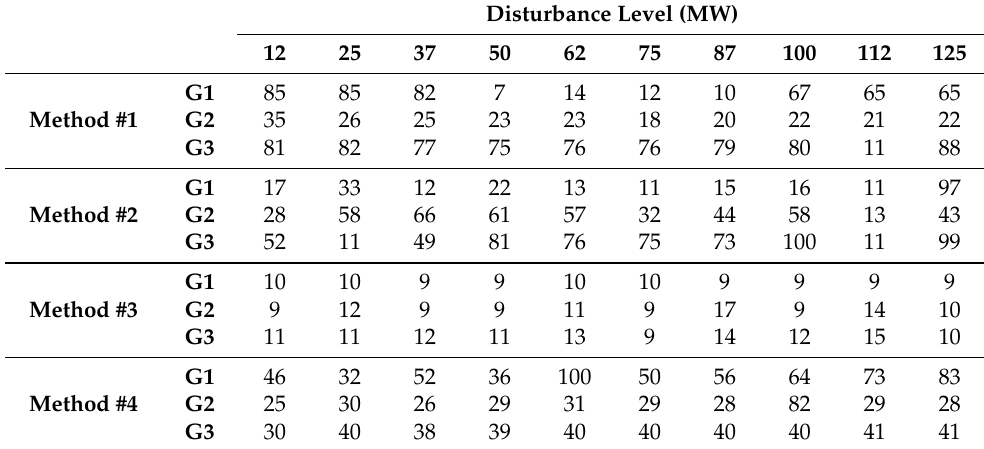
Table 8. Optimal K values under different disturbance levels.